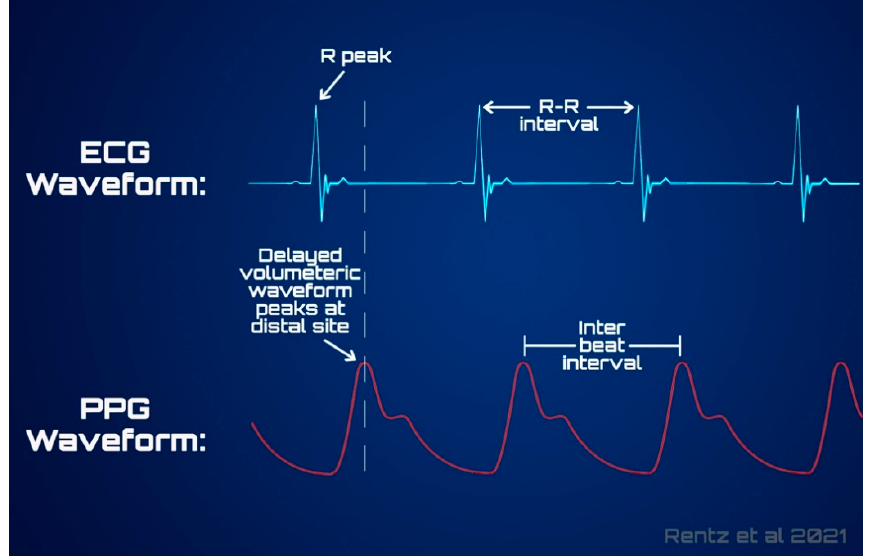
Figure 3. A comparison of cardiovascular signals in wearable devices. The electrocardiogram (ECG) waveform is shown relative to the volumetric waveform obtained via photoplethysmography (PPG). Of note, the volumetric changes that are demonstrated in the PPG waveform captured at a distal anatomical location travel slower than the electrical impulses that are captured by ECG, resulting in a slight delay of features, though highly proportional to that of ECG.